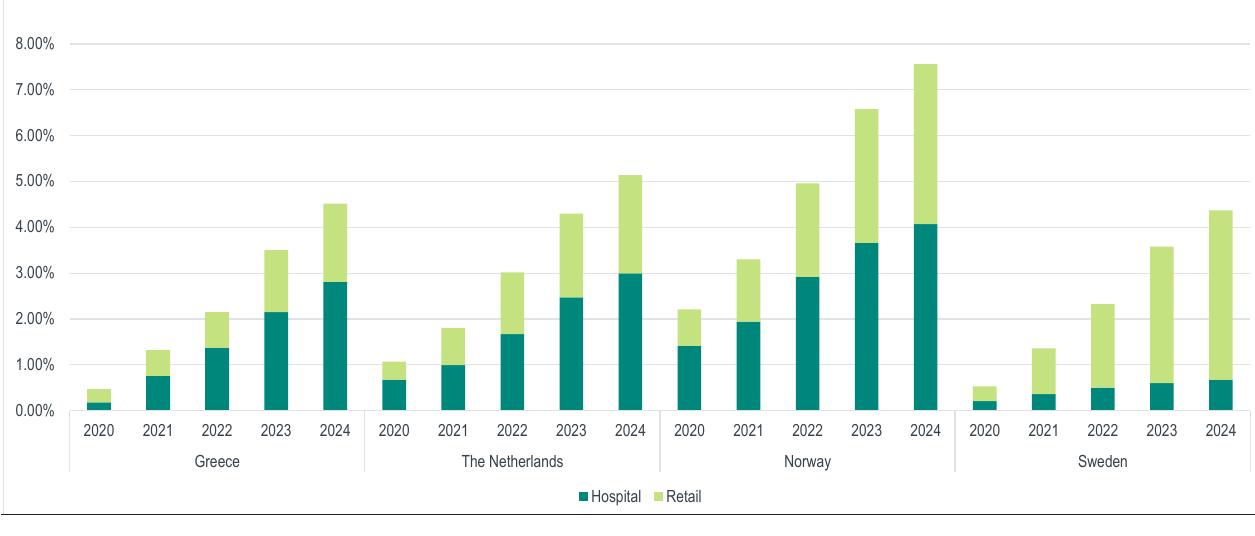
Table 3. Estimated Budget Realized as a Result of LOE and as a Share of Annual Drug Budget, 2020-2024 Estimated Budget Made Available, by Year